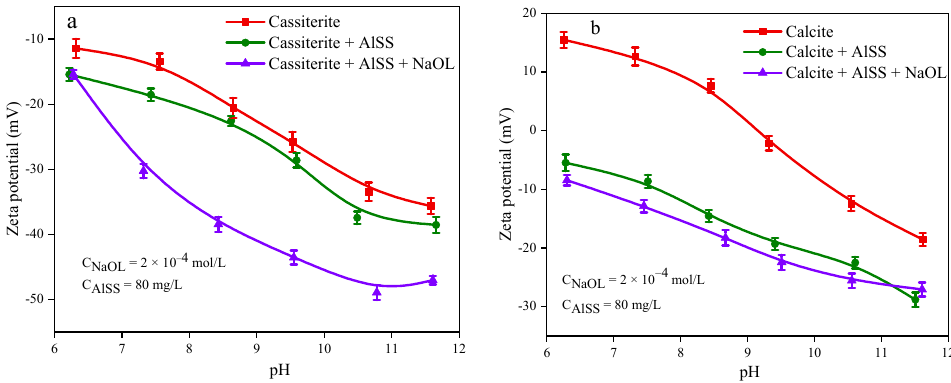
Figure 8. Effect of pH on the zeta potential of cassiterite ( a ) and calcite ( b ) in different systems.